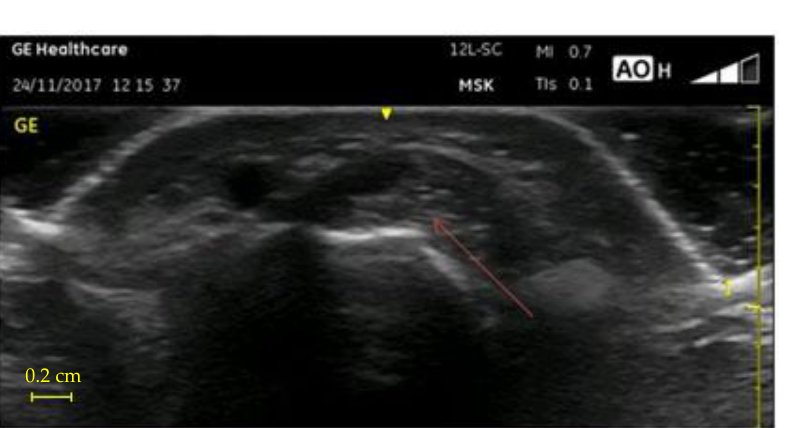
Figure 4. Ultrasonographic transverse image of the abductor pollicis longus and the extensor pollicis brevis, showing an increase in size and the presence of hypoechoic areas in the structure of the tendons.